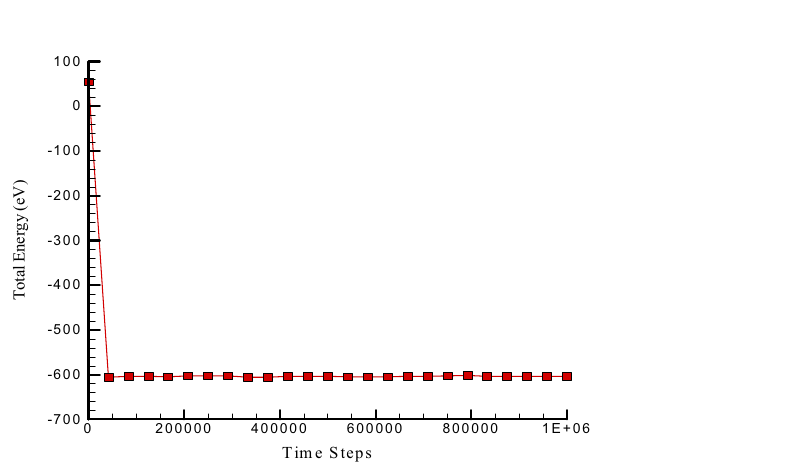
Figure 3. Total energy changes versus time for pristine concrete matrix.